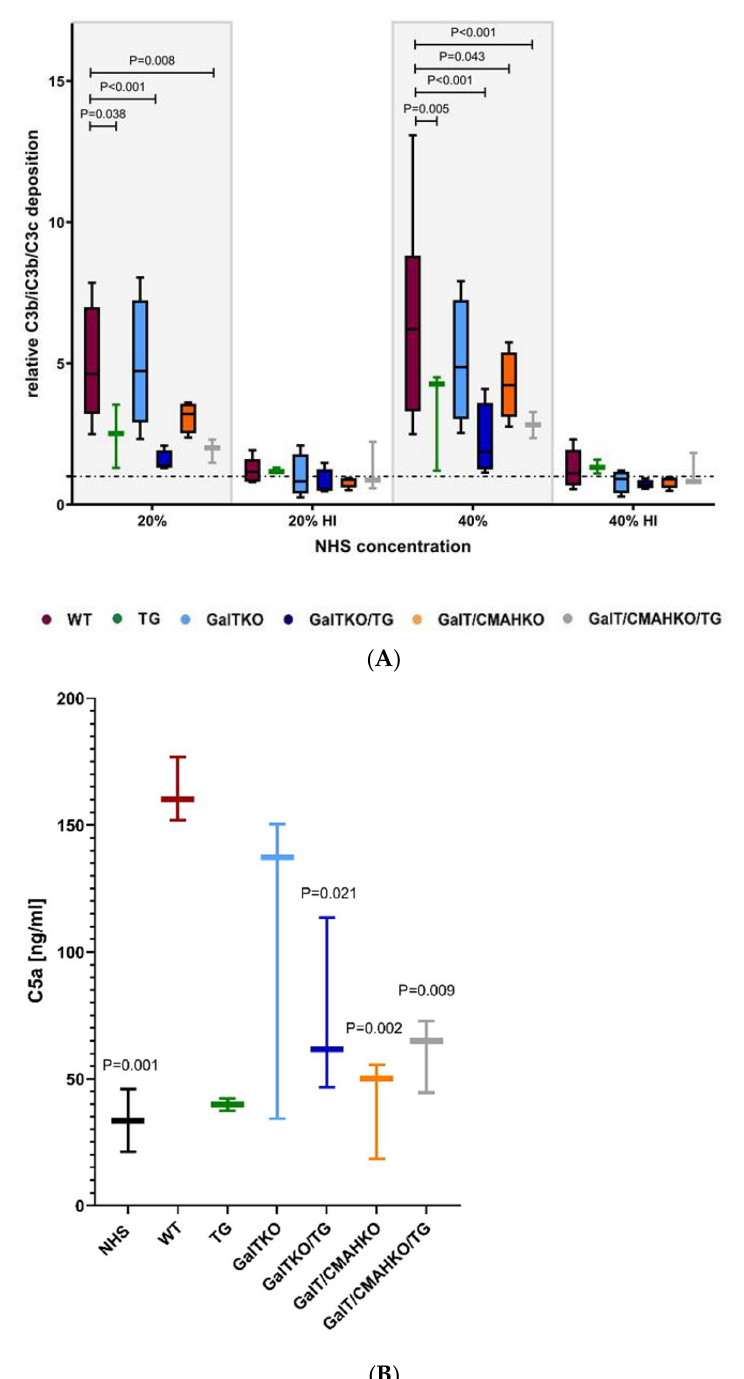
Figure 5. Xenoprotective properties of genetically modified chondrocytes on C3/C5 convertase level. Activated C3 (C3b, iC3b, C3c) deposition on porcine chondrocytes were quantified by specific cell ELISA after exposure the NHS (20% or 40% and heat-inactivated). Results were normalized to DNA content (determined by Hoechst staining) and are given in the diagram as ratio to unstimulated chondrocytes (dotted line) ( A ). Additional, C5a formation was determined in supernatants of NHS (40%) treated chondrocytes and NHS alone served as control ( B ). The variant TG was excluded from the statistical analysis due to low number of donors. Statistical analysis was done by two-way ( A ) or one-way ANOVA ( B ) with Dunnett’s multiple comparisons test. p -values are given for significant differences compared to WT, n =